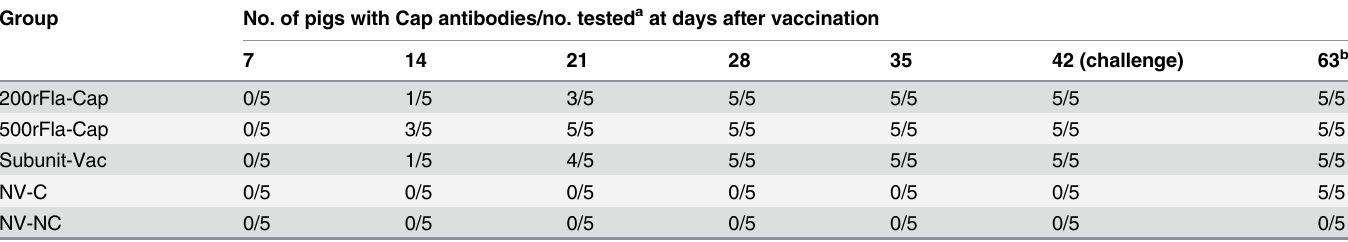
a Sera of all the fi ve pigs from each group were taken at the indicated times after vaccination. b Sera of all the fi ve pigs from each group were taken at 21 days after PCV2